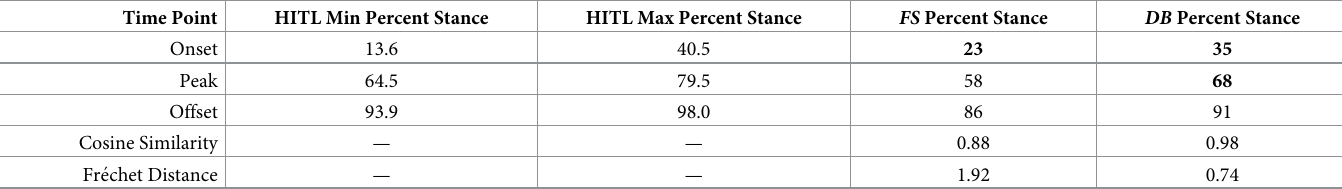
Table 3. HITL key point range for running at 3.0 m/s as reported by Witte et al. [10] and the corresponding points on the different methods at 3.0 m/s. Bold numbers fall withing the HITL range. The cosine similarity represents the overall similarity of profile to the HITL profile, values close to 1 are more similar to the HITL profile. Fre´- chet distance also represents similarity but is a measure of maximum distance, where smaller values are more